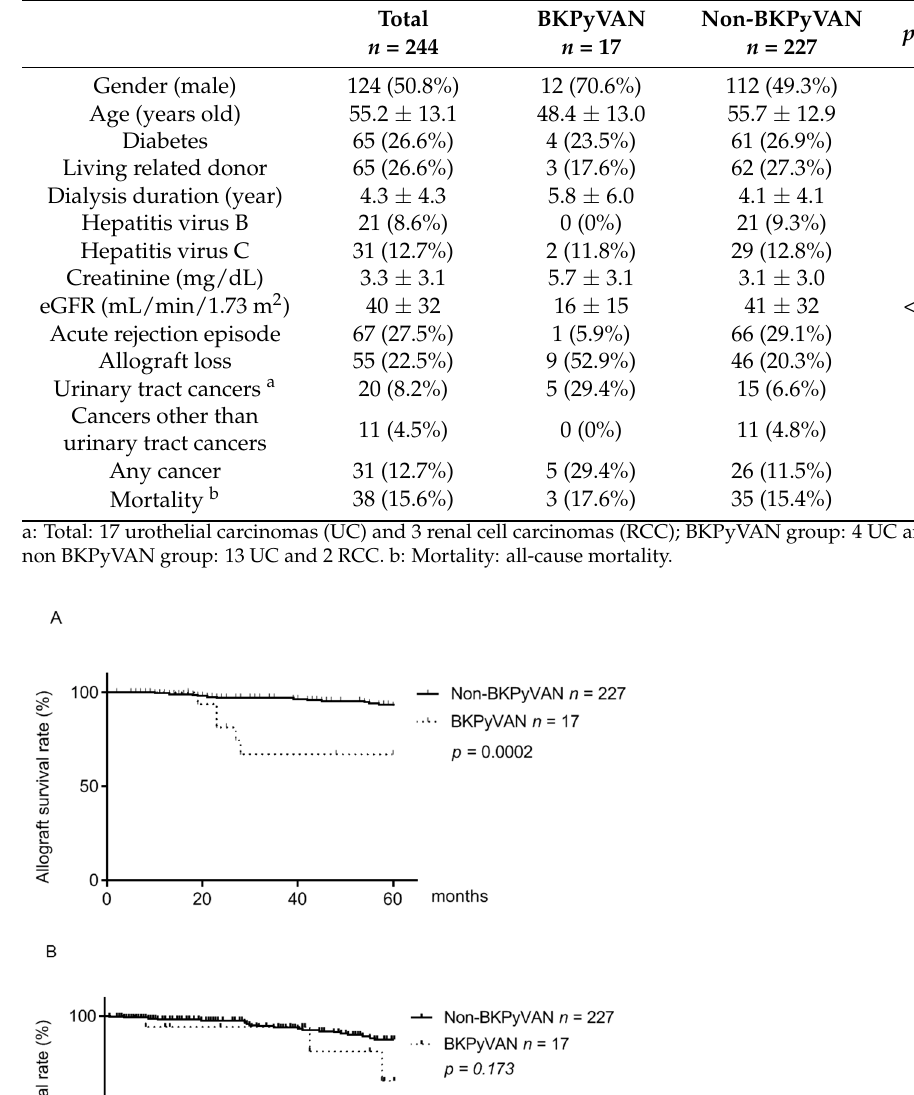
Table 1. Clinical characteristics of kidney transplant recipients with/without BKPyVAN.